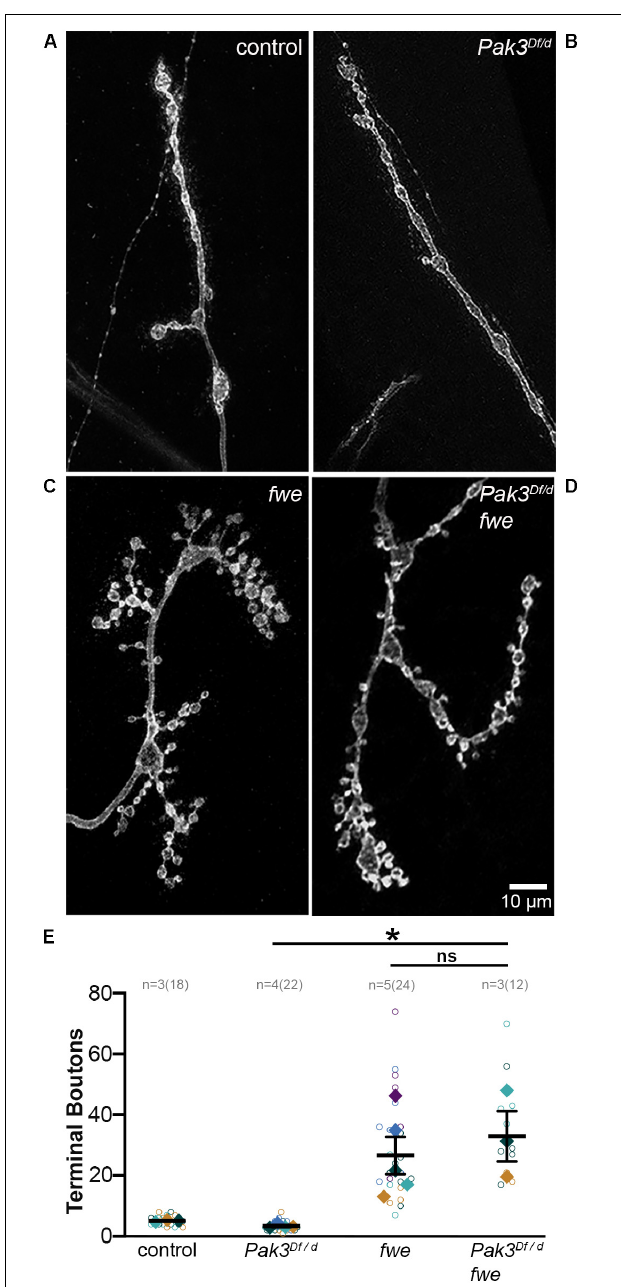
FIGURE 4 | Pak3 loss of function does not rescue all supernumerary bouton mutants. (A–D) Anti-HRP staining shows neuronal morphology at the NMJ. (A) Wild type synaptic boutons are arrayed linearly with only a few branches and (B) Pak3 loss of function mutants, Pak3 Df / Pak3 d 02472 , show no differences from wild type. (C) Loss of function mutations in flower ( fwe DB 56 / fwe DB 25 ) result in extreme branching of the neuronal arbor and small bouton size, similar to spastin mutant morphology. (D) Loss of Pak3 function does not rescue the supernumerary bouton phenotype in fwe mutants, indicating that Pak3 loss is not a generalized mechanism to reduce extra synaptic branching. (E) Individual terminal bouton numbers (open circles) and larval averages (solid diamonds) are shown for each of the genotypes in (A–D) . Significant differences are calculated by one-way ANOVA and Sidak’s multiple comparisons test. * denotes 0.01 < p ≤